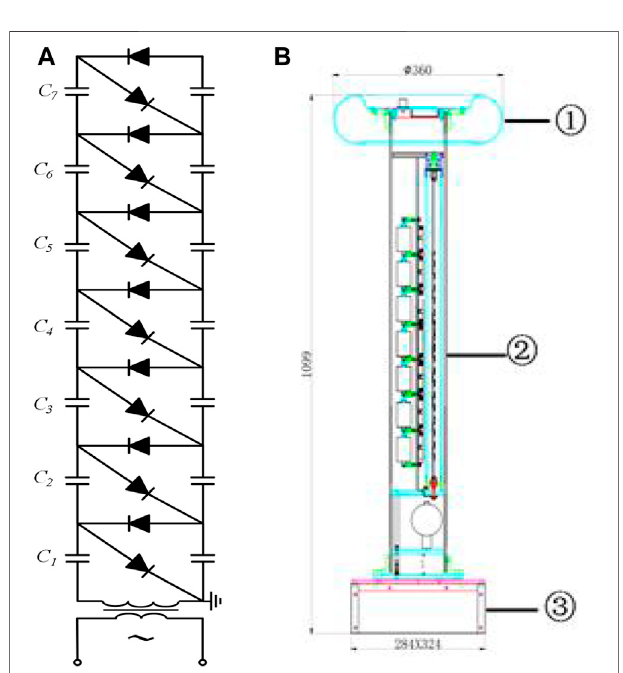
FIGURE 3 | Voltage-doubler recti fi er circuit. (A) Schematic diagram; (B) Design